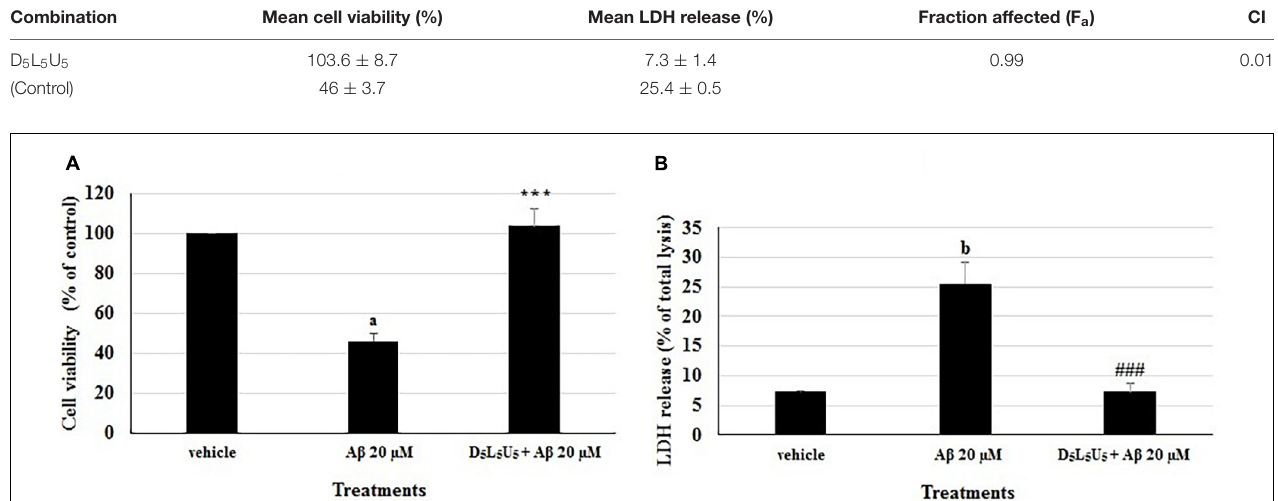
TABLE 2 | Predicted three-compound combination D 5 L 5 U 5 and its combination index derived by CompySyn v. 1.0. Combination